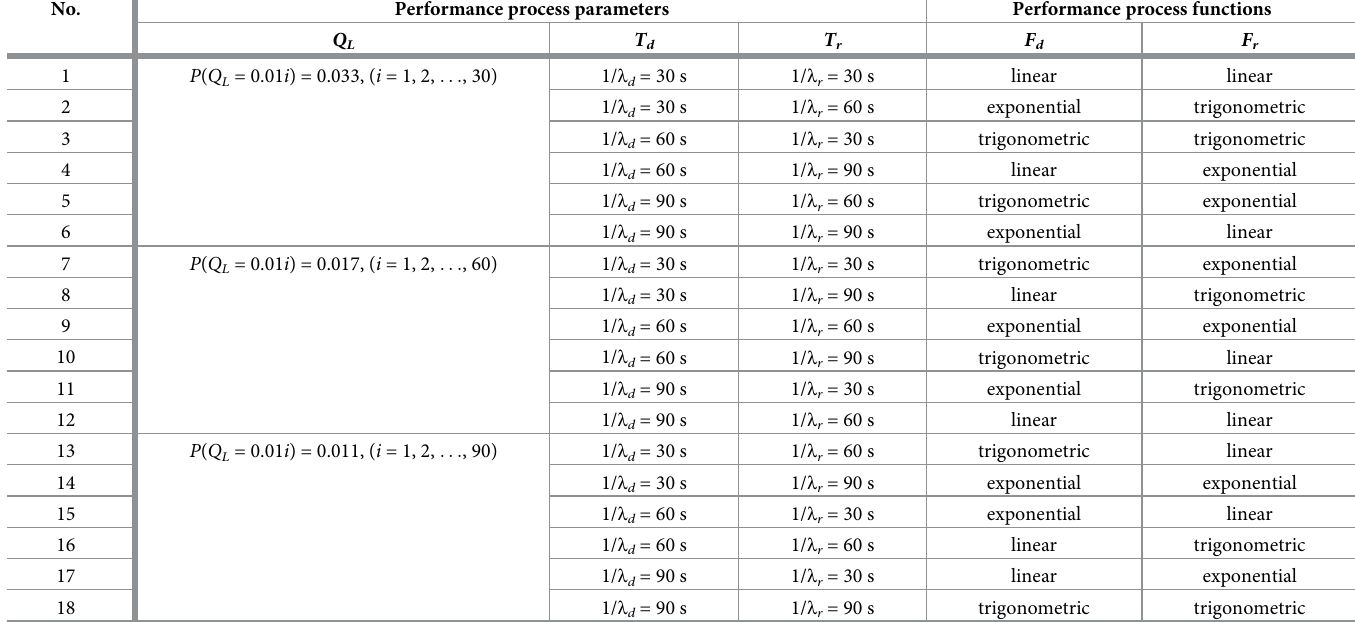
Table 2. Experimental